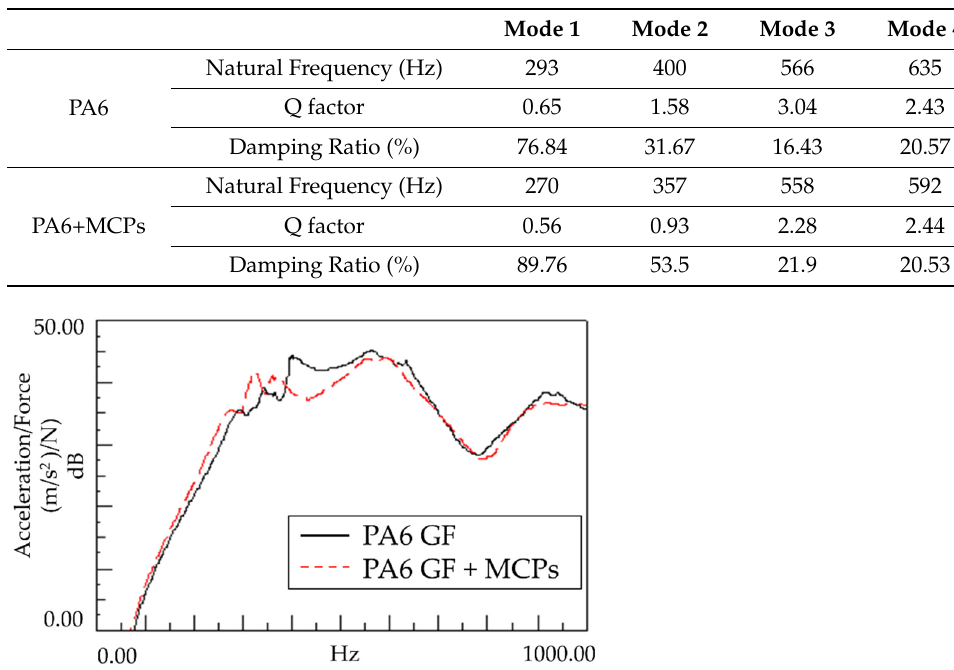
Figure 9. Vibration response of all points of the plate specimen. Table 2. Vibration characteristics from FRF curves from Figure 10.